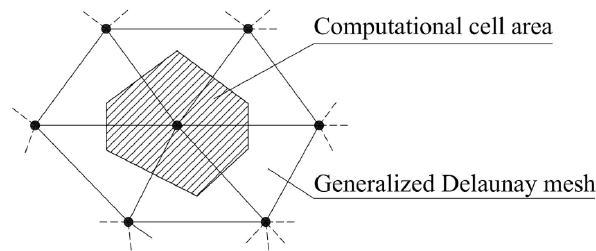
Figure 8. Computational mesh of WEC-FLOOD model. The ver- tices of each cell (black dots) are the computational centers of the cells (i.e., the point at which the water surface is computed for the cell) and are obtained as the circumcenters of the generalized De- launay